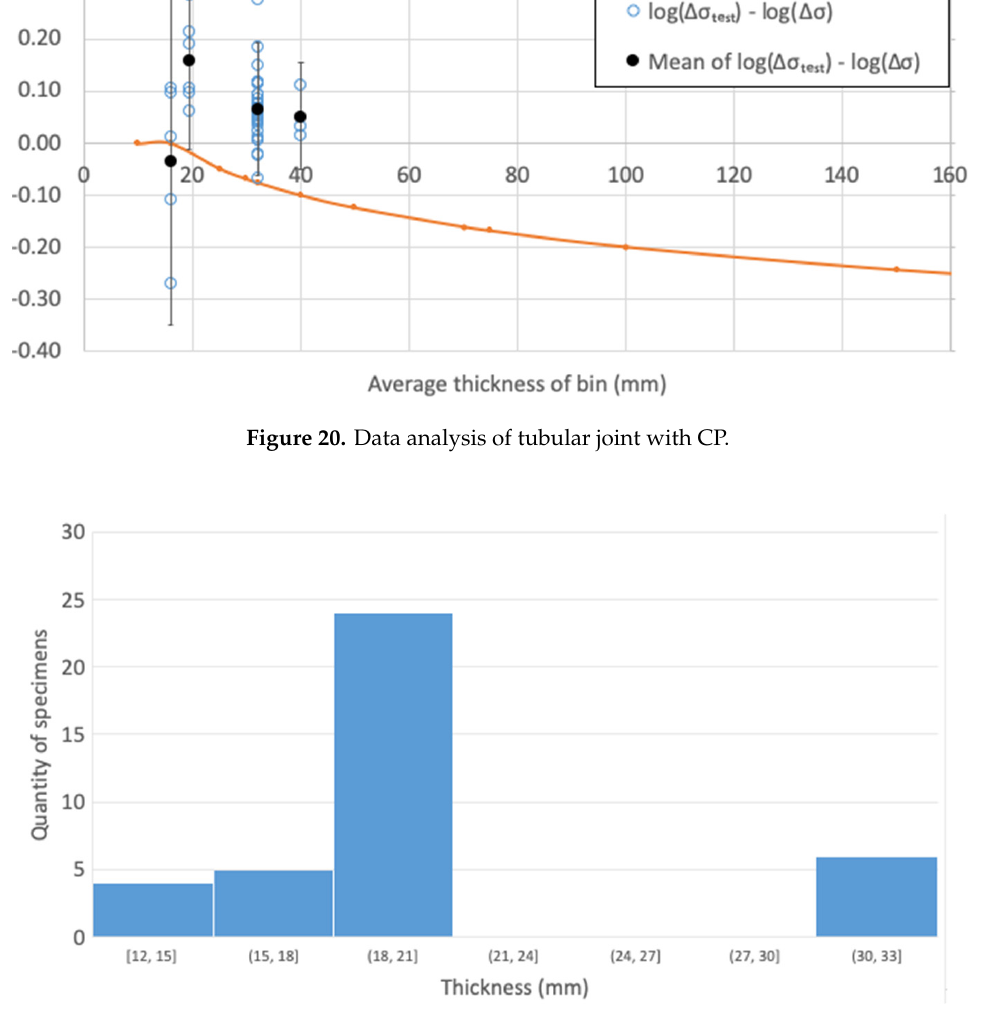
Figure 22. Data analysis of tubular joint with CP .